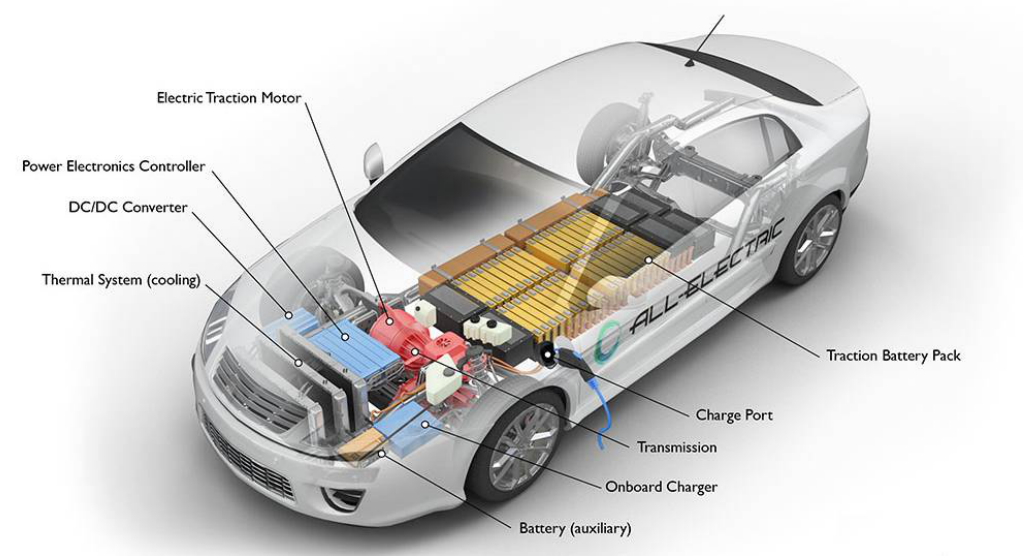
Figure 16. Schematic of a battery electric vehicle [78].